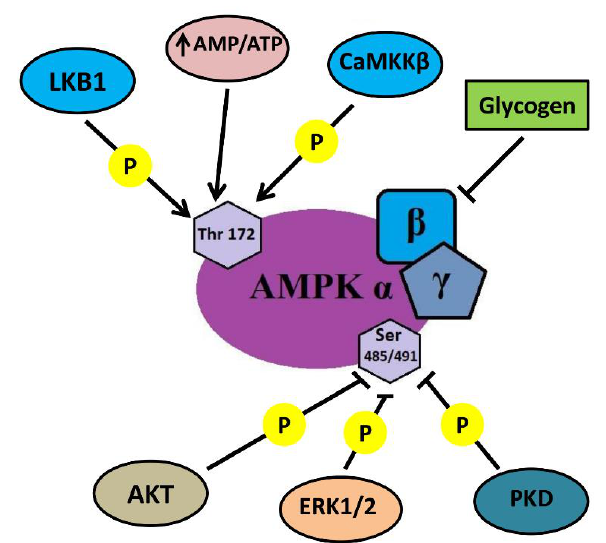
Figure 1. Upstream influences on AMP-activated protein kinase (AMPK). Liver kinase B1 (LKB) and calcium-calmodulin kinase II (CaMKKII) can phosphorylate AMPK at Thr172 site and increase the activity of its reaction center. The phosphorylation of this site is also facilitated by AMP. Phosphorylation at Ser 485 / 491 site reduces the level of Thr172 phosphorylation and, accordingly, AMPK activity. AMPK Ser 485 / 491 phosphorylation can be mediated by AKT (protein kinase B), mitogen-activated protein kinase (ERK1 / 2), and protein kinase D (PKD). An interaction with glycogen via the β subunit also reduces the level of AMPK (Thr172) phosphorylation and its activity. Thus, AMPK activity is the result of an interaction of both activating and inhibiting influences.